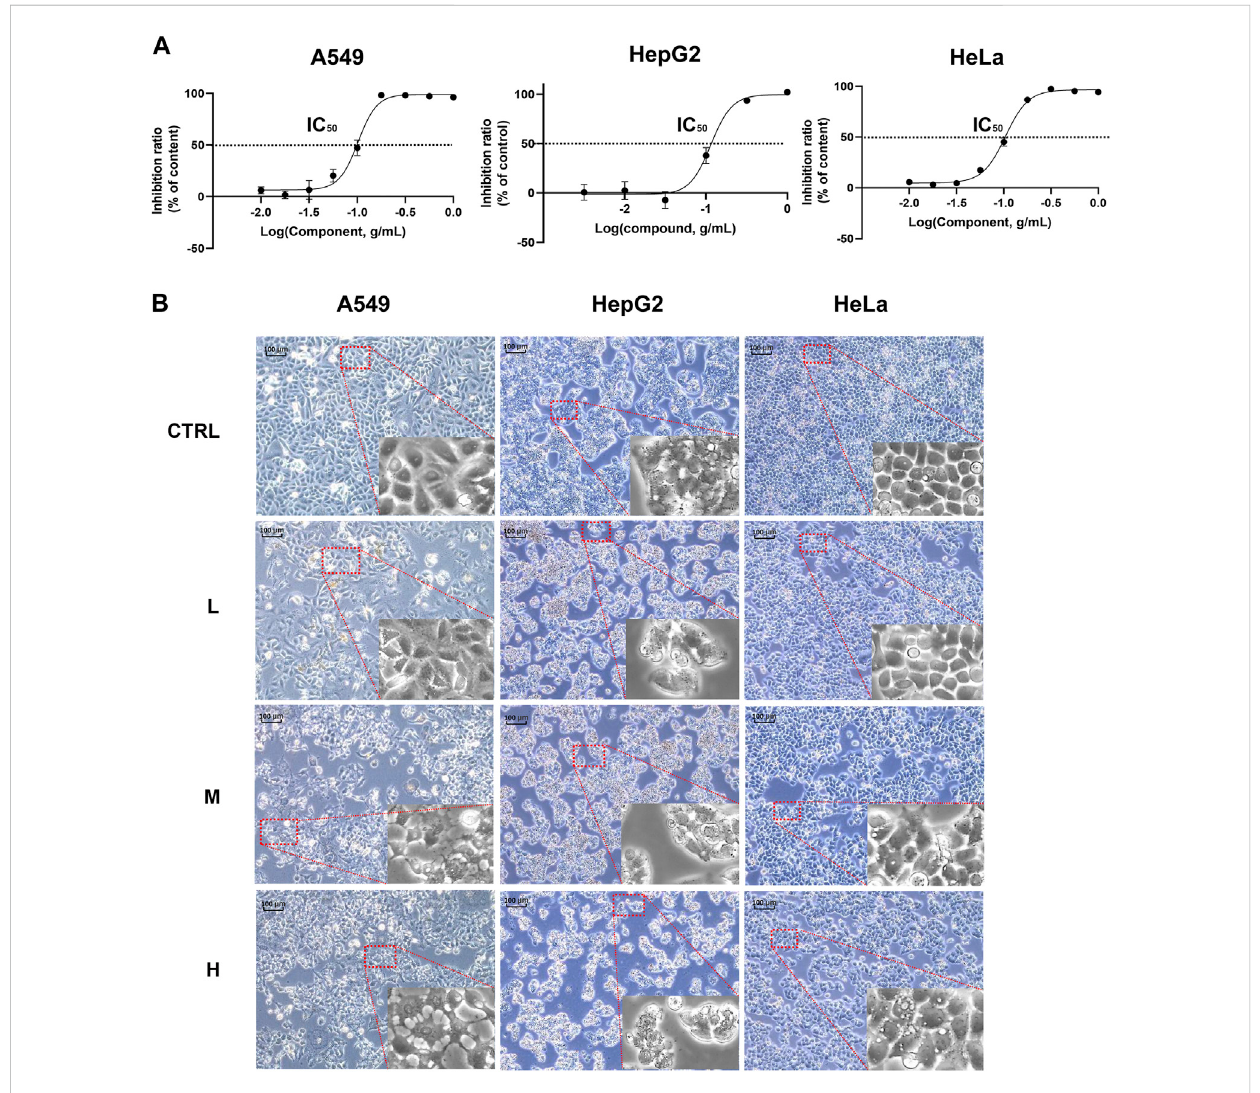
FIGURE 8 CRinhibitedA549,HepG2,andHeLacellgrowth. (A) A549,HepG2,andHeLacellviabilityweredeterminedwithCCK8assay. (B) A549,HepG2,and HeLa morphology changes after CR treatment with 24